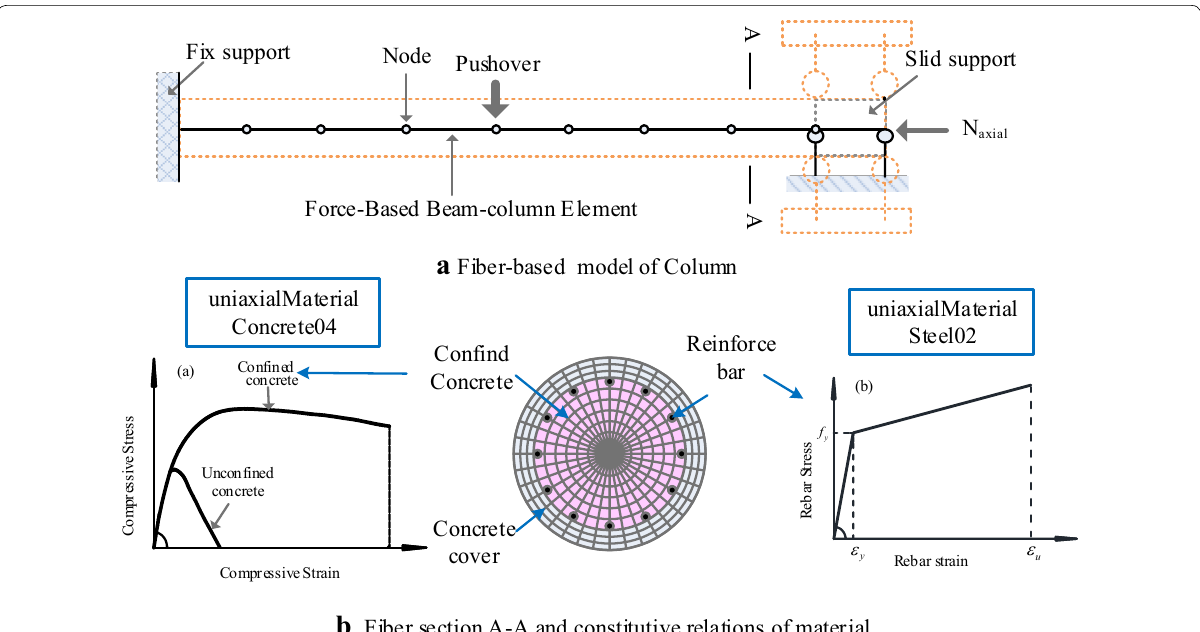
Fig. 12 Fiber-based beam-column model for axially-loaded RC